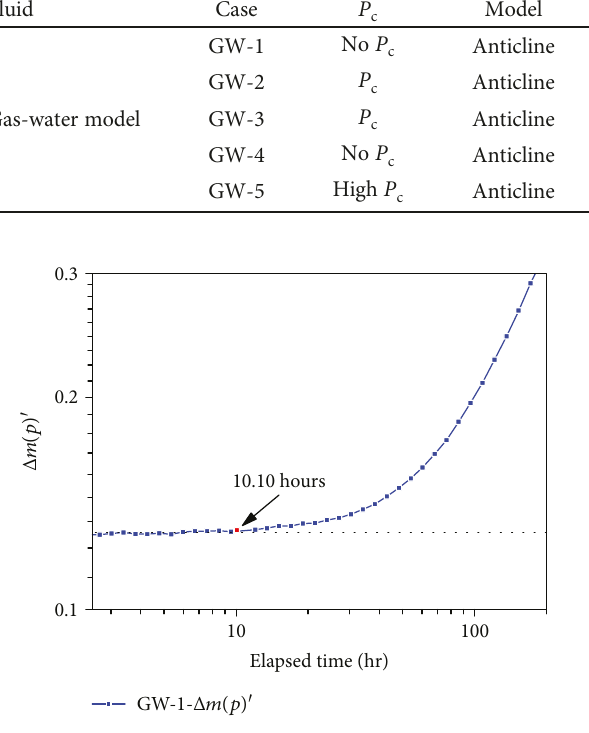
Figure 17: The total mobility curve at upstream saturation front ( r → r + ), from 10.10 hours. The total mobility starts to decrease f